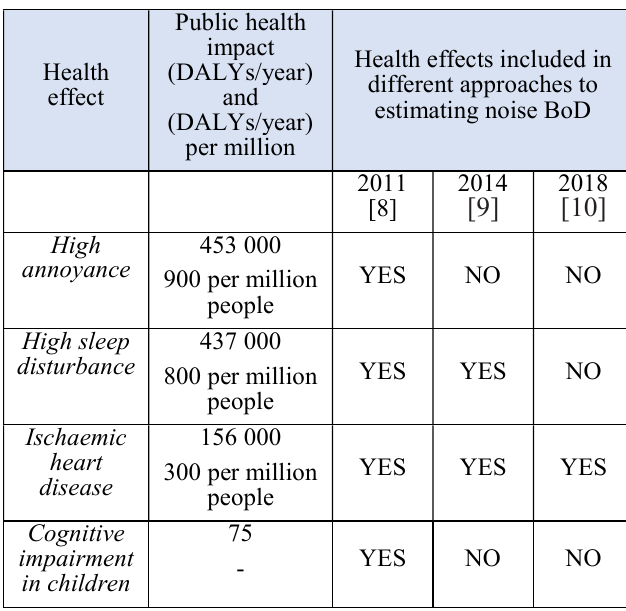
Table 5. Recommended health outcomes for assessing the impact of road traffic noise on the health of residents